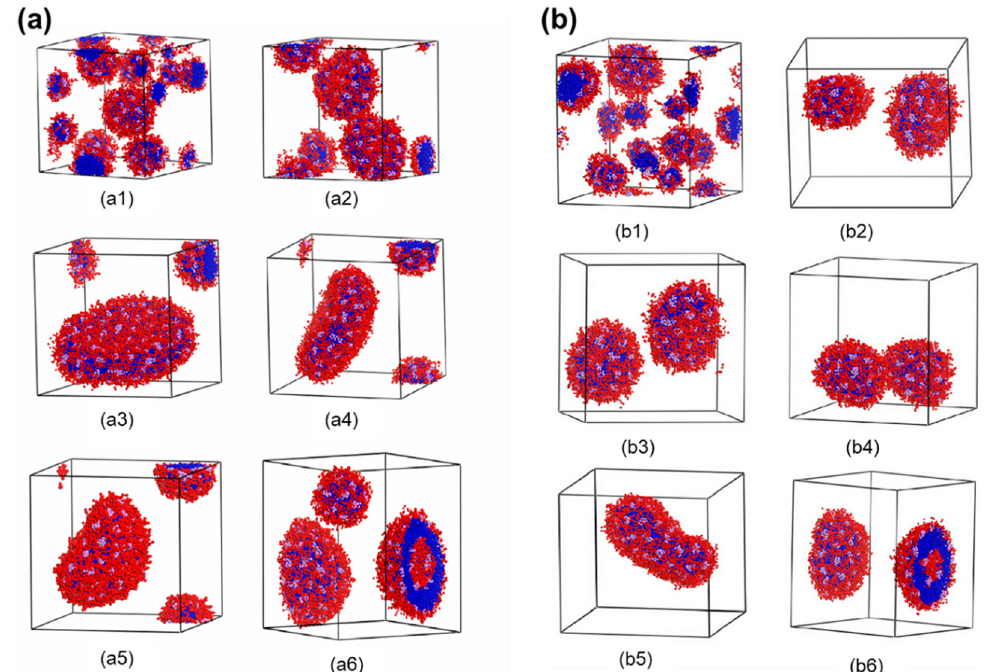
Figure 3. ( a ) Typical formation process of raspberry vesicle self-assembled from E 12 O 6 F 2 with a polymer concentration of 𝒇 𝒑 = 𝟎.𝟏𝟓 at ( a1 ) 50,000 DPD steps; ( a2 ) 150,000 DPD steps; ( a3 ) 175,000 DPD steps; ( a4 ) 200,000 DPD steps; ( a5 ) 210,000 DPD steps; and ( a6 ) 250,000 to 500,000 DPD steps. ( b ) Typical formation process of raspberry vesicle self-assembled from E 12 O 6 F 2 with polymer concentration of 𝒇 𝒑 = 𝟎.𝟏 at ( b1 ) 50,000 DPD steps; ( b2 ) 280,000 DPD steps; ( b3 ) 350,000 DPD steps; ( b4 ) 424,000 DPD steps; ( b5 ) 470,000 DPD steps; and ( b6 ) 500,000 to 800,000 DPD steps. The blue, red, and pink colors represent E, O, and F, respectively, while solvent molecules are omitted for clarity.